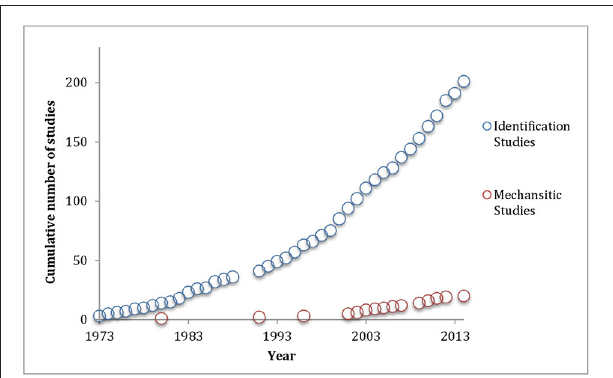
FIGURE 1 | Temporal trend in the cumulative number of studies that identify parasite-host manipulation ( n = 201) and those that attempt to elucidate the mechanism behind said manipulation ( n = 20) in helminth studies from 1973 to 2014 (data from Poulin and Maure,